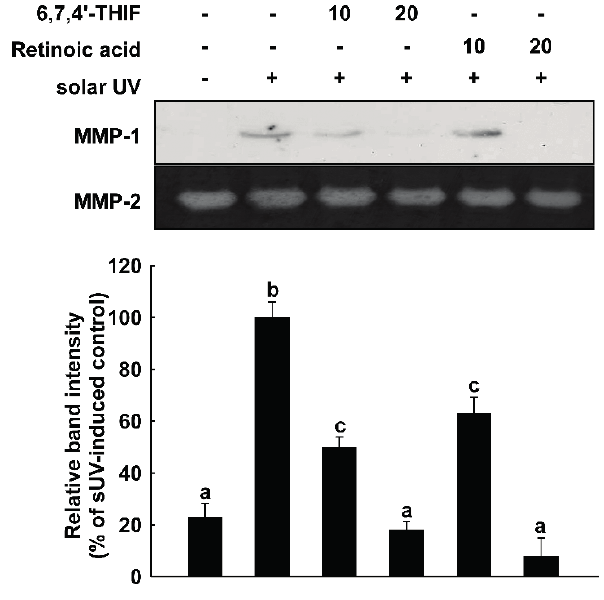
Figure 6. 6,7,4'-THIF shows a better inhibitory effect than retinoic acid on sUV-induced MMP-1 expression. The cells were pretreated with 6,7,4'-THIF for 1 h and irradiated with sUV. The media was collected after 48 h of sUV exposure. The MMP-1 expression level was measured by western blot analysis as described in the Materials and Methods. Means with different letters (a–c) within a graph were significantly different from each other at p <